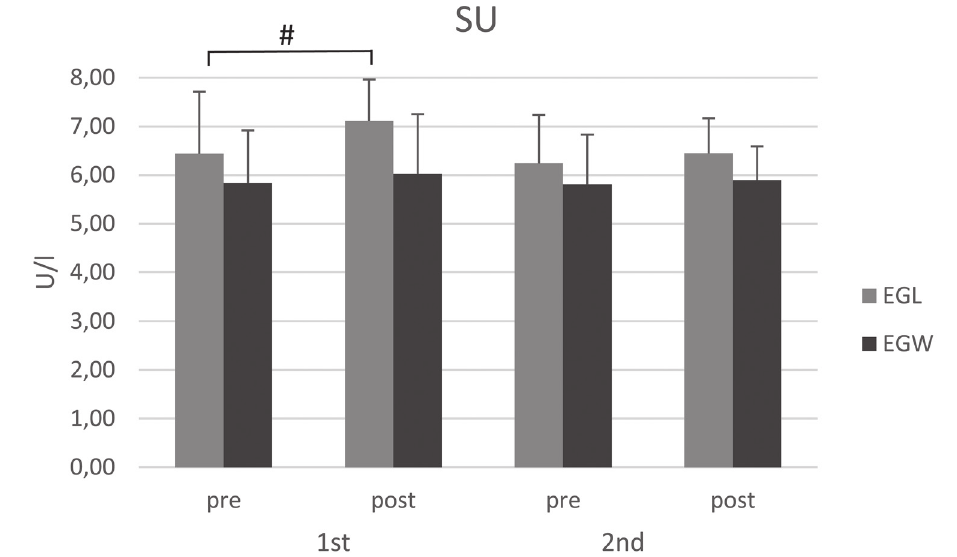
FIGURE 3 Serum urea results before (pre) and after (post) the first (1st) and last (2nd) plyometric training session Note: # indicates a significant difference (p<0.05) between the results before (pre) and after (post) the plyometric training